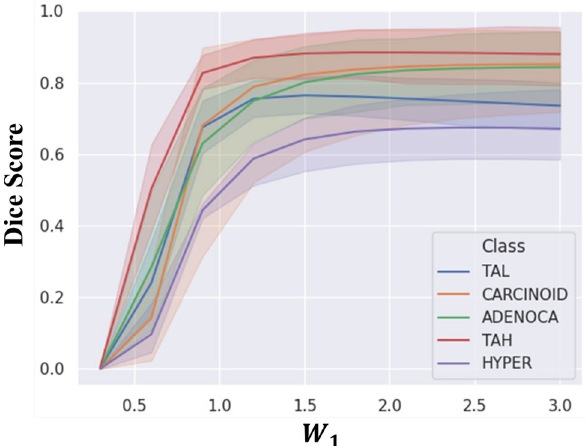
Figure 2. Change in Dice in all tumor classes according to the low-frequency weight ( W 1 ) in the